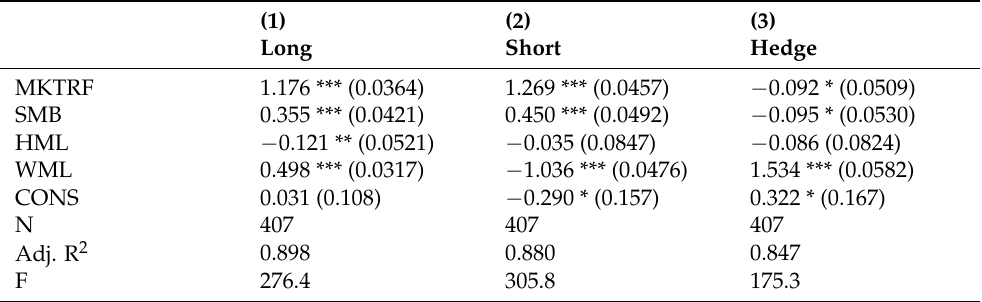
Table 4. Four factors alpha and momentum portfolio.